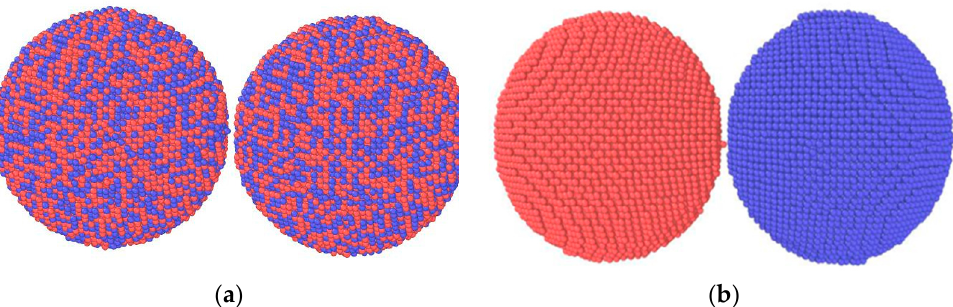
Figure 2. Spherical particle model (red refers to Ti, blue refers to Al): ( a ) alloy particle system, ( b ) elemental particle system.